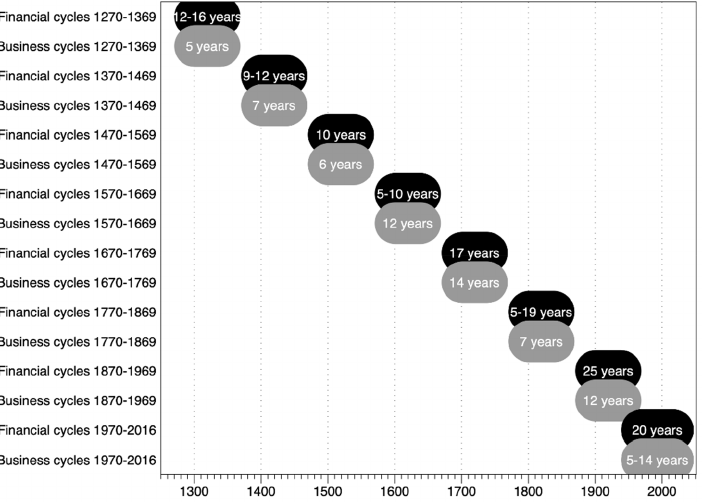
Figure 3. Financial and business cycles synchronisation in the UK 1270–2016 (source: authors’